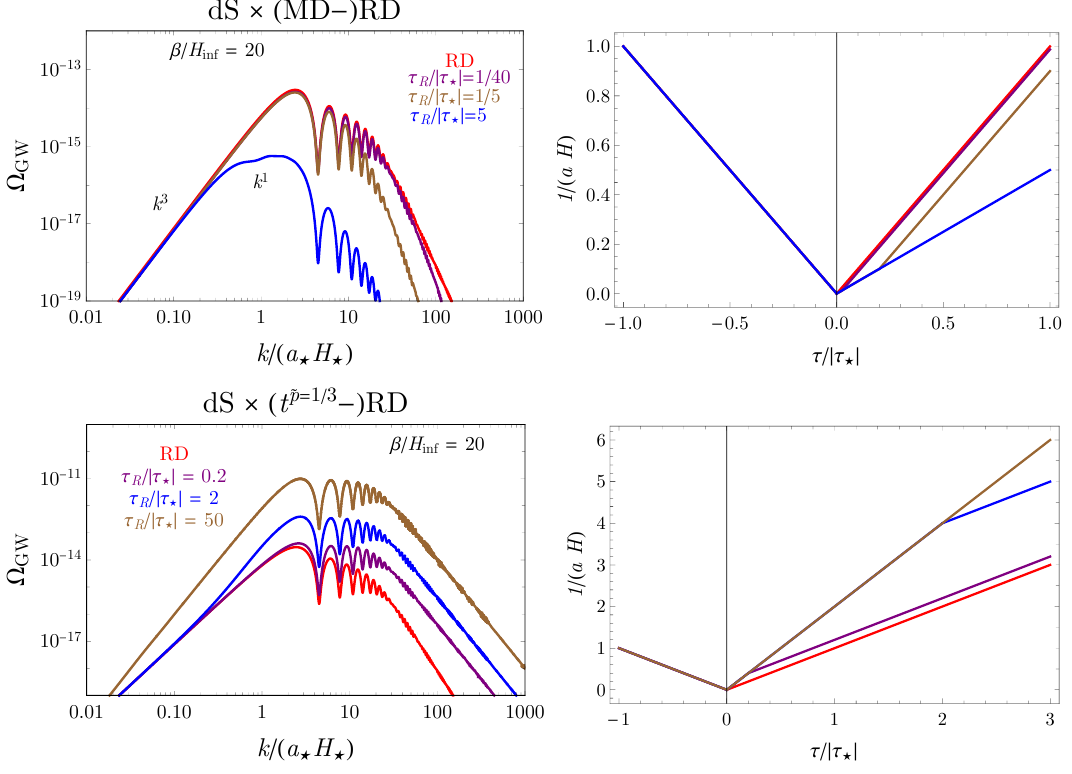
Figure 8 . Left: GW spectrum from first-order phase transition during the quasi-de Sitter inflation, in scenarios with an MD intermediate stage before the RD era in the left upper panel and with an KD intermediate stage before the RD era in the left lower panel. The brown, blue and purple curves are for different τ R / | τ ? | settings. As a comparison, the GW spectrum for the instantaneous reheating scenario is shown as the red curve. For all the scenarios β/H inf is fixed to be 20. Right: the evolution of 1 / ( aH ) for the scenarios shown in the left